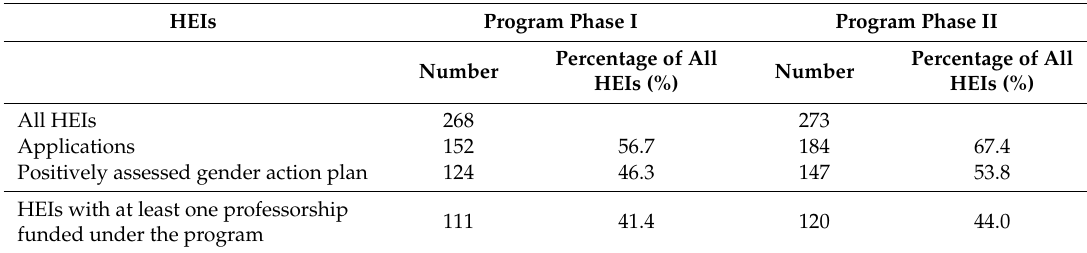
Table 1. Overview of All HEIs, Submissions, Positive Assessments, and